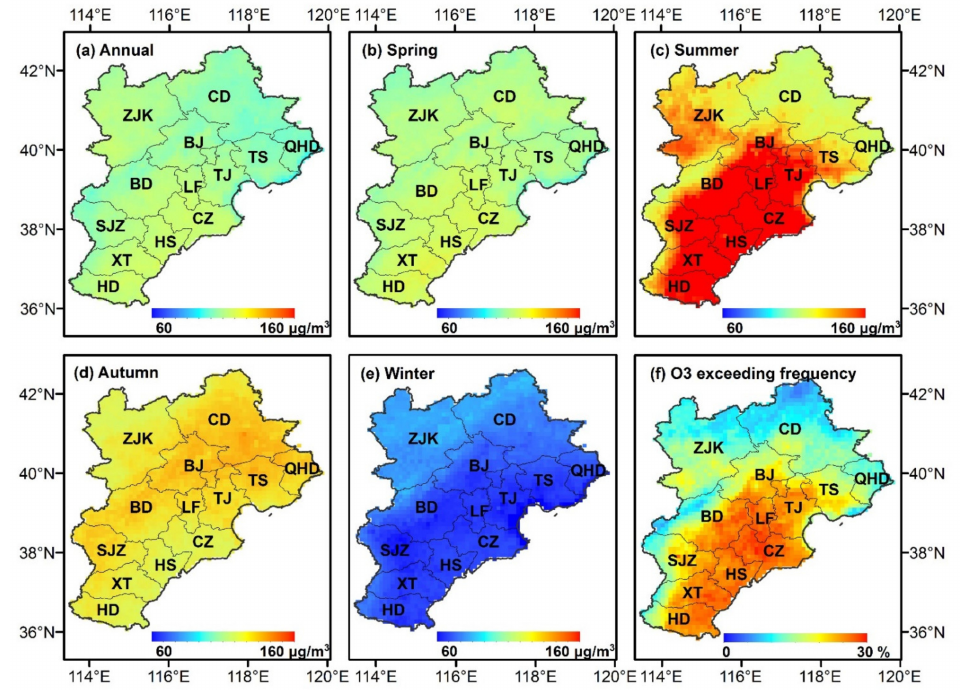
Figure 7. Spatial distributions of the annual average ( a ) and seasonal average MDA8 O 3 concentration estimated from the WRFC-XGB model ( b – e ) and the O 3 exceedance frequency ( f ) in the BTH region (Beijing (BJ), Tianjin (TJ), Chengde (CD), Qinhuangdao (QHD), Tangshan (TS), Zhangjiakou (ZJK), Baoding (BD), Langfang (LF), Cangzhou (CZ), Shijiazhuang (SJZ), Hengshui (HS), Xingtai (XT), and Handan